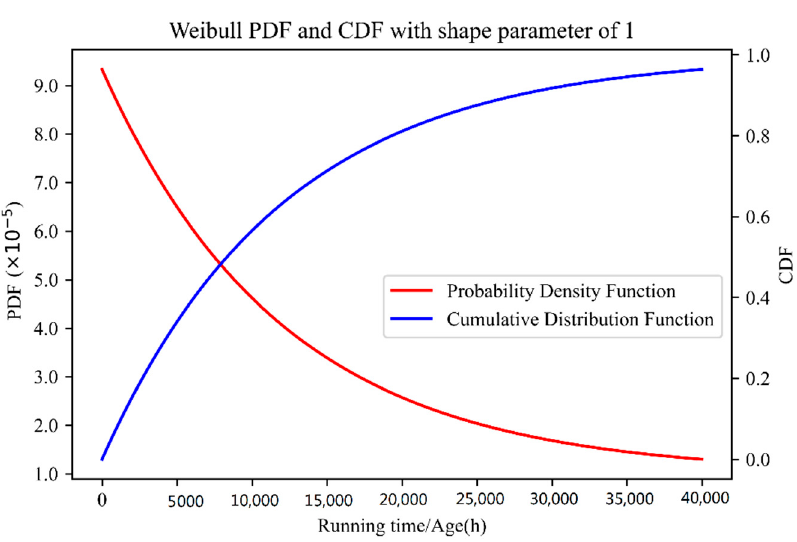
Figure 11. Relationship of creep–fatigue life and damage amount of final superheater TP347H material.